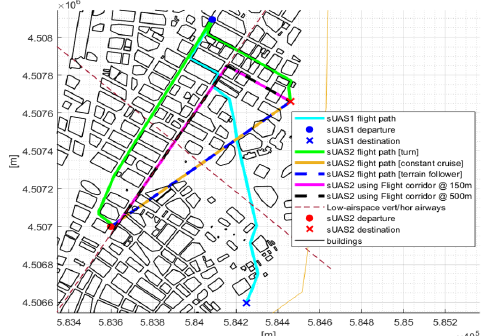
Figure 19. Top-down view of sUAS 2 sample solutions. Five flight trajectory solutions are generated for sUAS 2 . Each solution provides route deconfliction from Manhattan terrain and building geofences and from the sUAS 1 flight trajectory geofence. Distances traveled are 2008 m (turn), 1585 m (constant cruise), 1634 (terrain follower), 1983 (150 m flight corridor), and 2395 (500 m flight corridor). The minimum-cost solution for sUAS 2 is the constant cruise altitude